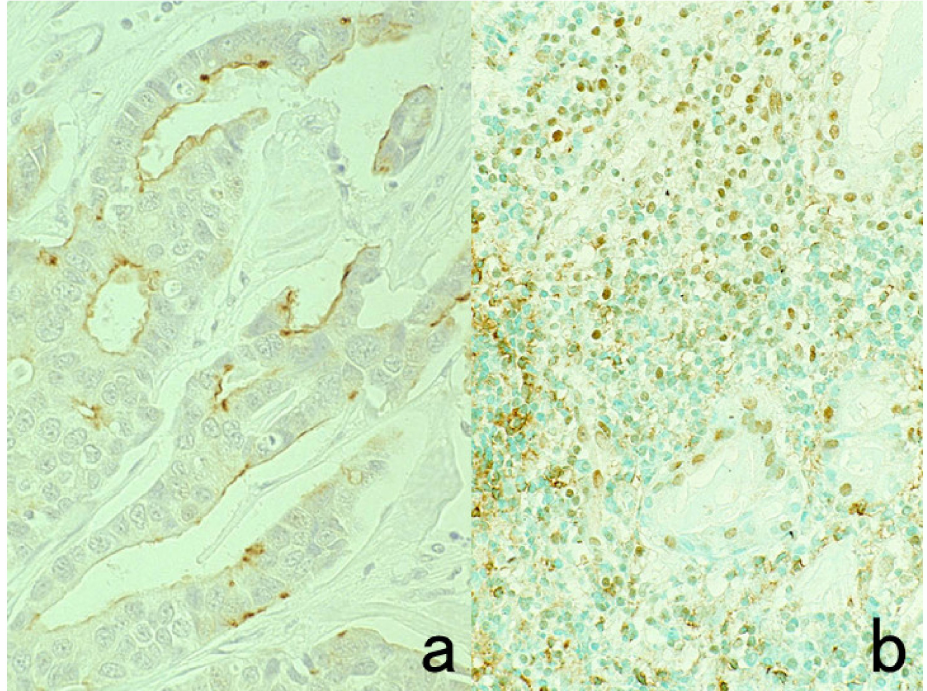
Figure 47. Examples of nonspecific immunostaining. ( a ): Membranous positivity of PgR in breast cancer and ( b ): nuclear positivity of CD45RO (UCHL1) in nasal NK-cell lymphoma. The intracellular localization pattern is unusual, so the results must be regarded as nonspecific. The nuclei in panel ( b ) are counterstained with methyl